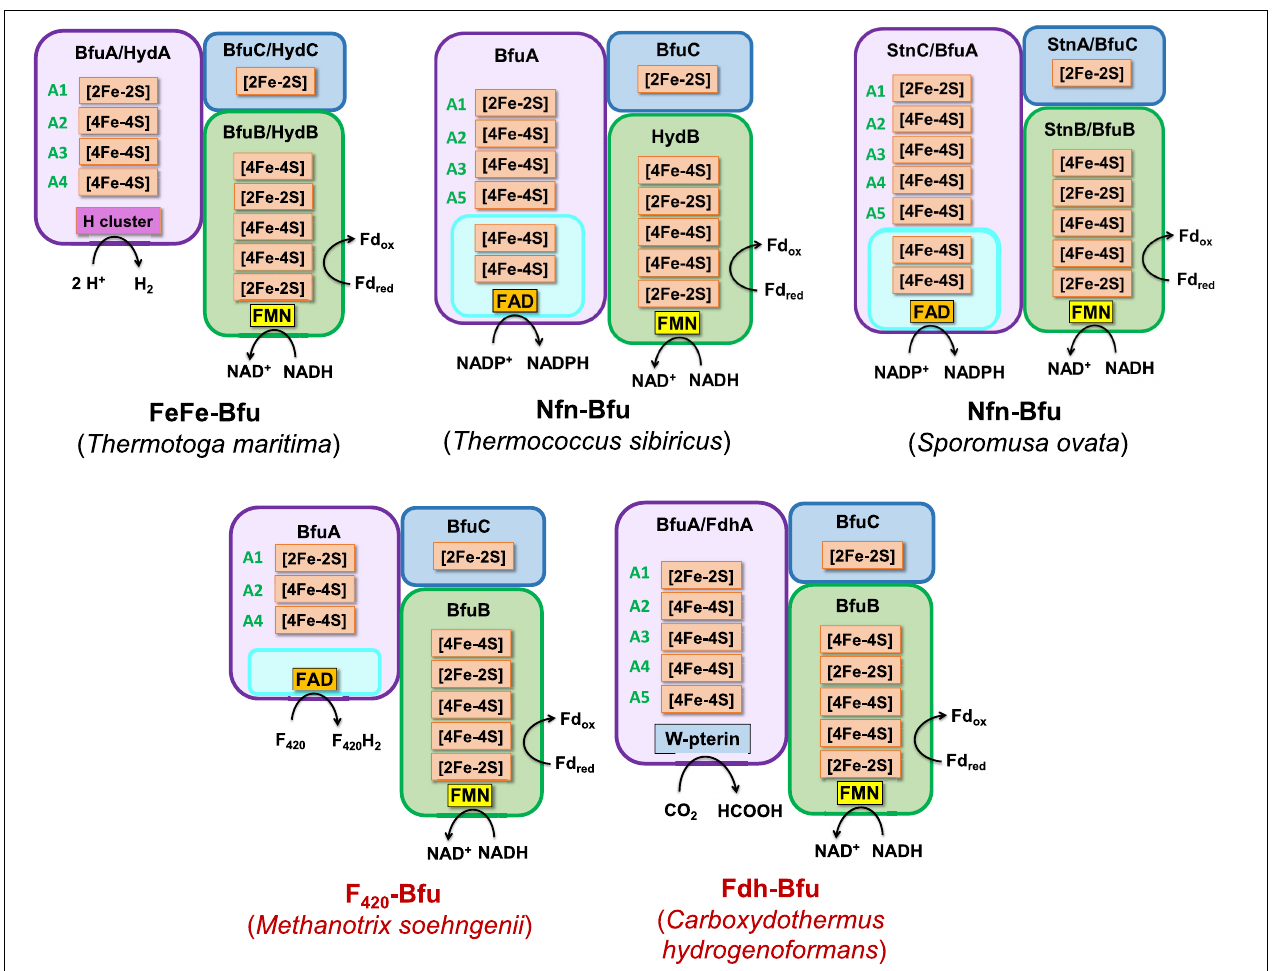
FIGURE 6 | Predicted subunits and cofactor contents of Type 1 Bfu enzymes. Characterized and predicted enzymes and their microbial sources are shown in black and red font, respectively. Each of the BfuA subunits of these enzymes contains an additional domain that enables the enzyme to interact with the third substrate [in addition to Fd and NAD(H)]. See text for